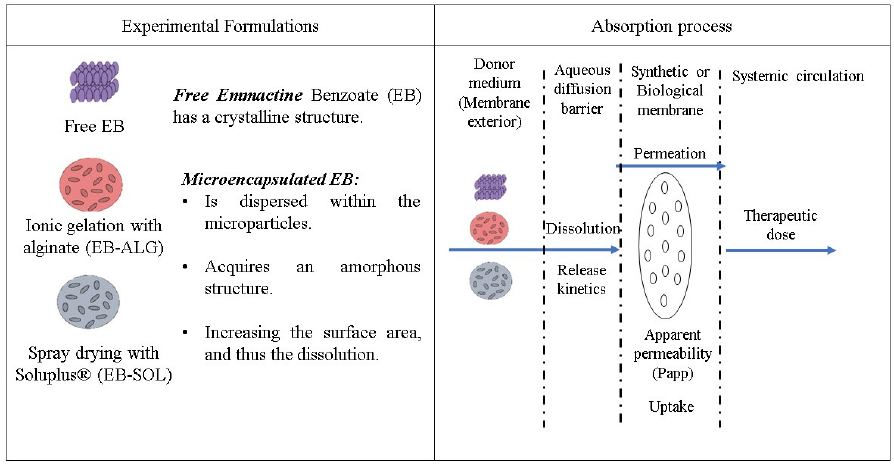
Figure 1. Experimental approach.